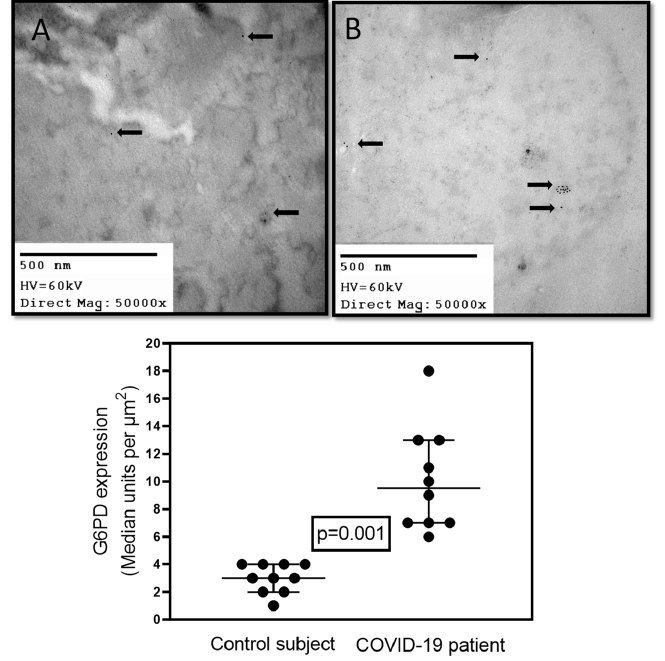
Figure 1. Representative immune-electron micrograph of lung. ( A ) Postmortem sample from a biopsy from a 59-year-old female control subject with hypertension, obesity, type 2 diabetes, and pneumonia. ( B ) Postmortem sample from a 68-year-old female patient with COVID-19 that had associated comorbidities of ischemic heart disease, type II diabetes, morbid obesity, and hypertension without G6PD deficiency. Two control subjects and two COVID-19 subjects were included. In each subject a lung biopsy was taken, and five electron micrographs × two fields were analyzed, and immunolabeling was performed as previously described by our group [8]. The primary G6PDH antibody (AB 87,230 ABCAM) and a secondary goat-anti-rabbit gold 15 nm (cat: 25,112 Electron Microscopy Sciences) were employed. In panels ( A , B ), the arrows indicate the presence of the immune colloidal 15 nm gold marker for G6PDH antibody. The images were taken at 50,000× with a Jeol JEM-1011 electron microscope (JEOL Ltd., Tokyo, Japan) to 60 kilovolts equipped with AMT 542.391 analysis software. The histogram represents the densitometry analysis of the gold particle count; the statistical analysis was performed with The GraphPad-Prism 6 Software. Inc. (San Diego, CA, USA), 1992–2012, which was used to generate the analysis and graph. Statistical significance was determined by the Mann–Whitney rank sum test followed by the normality test (Shapiro–Wilk). Difference was considered statistically significant when p ≤ 0.05.